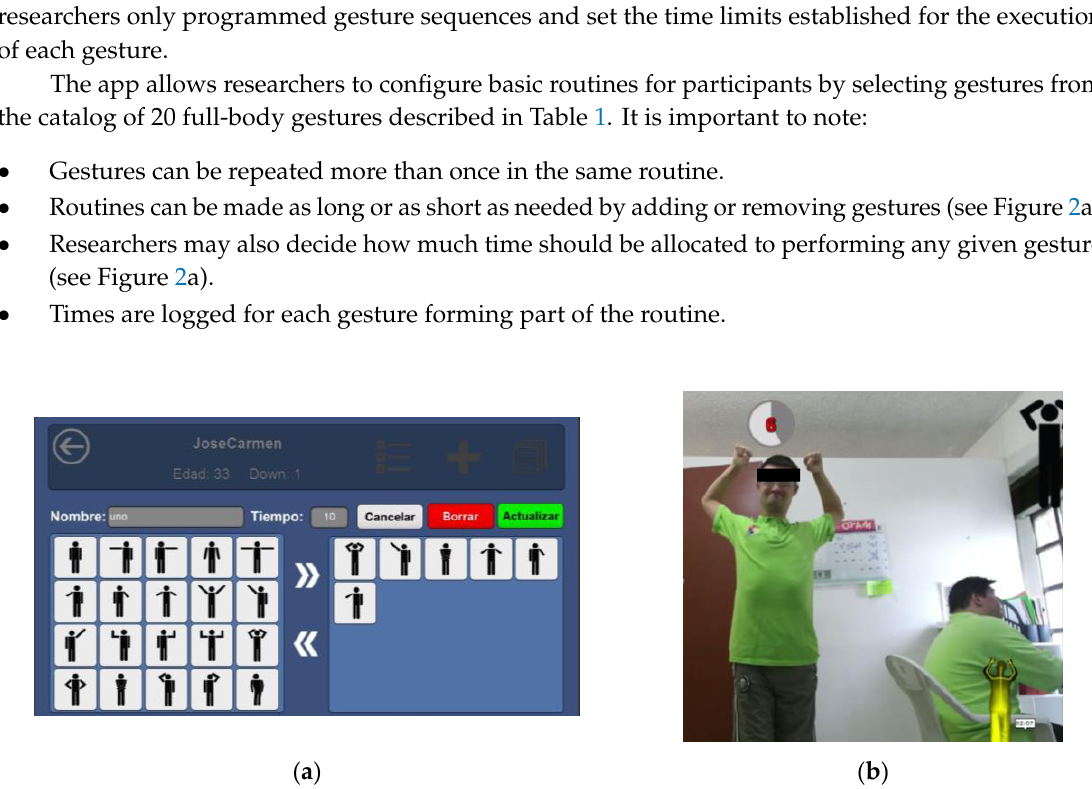
Figure 3. ( a ) User registration; ( b ) list of registered users; ( c ) list of tasks